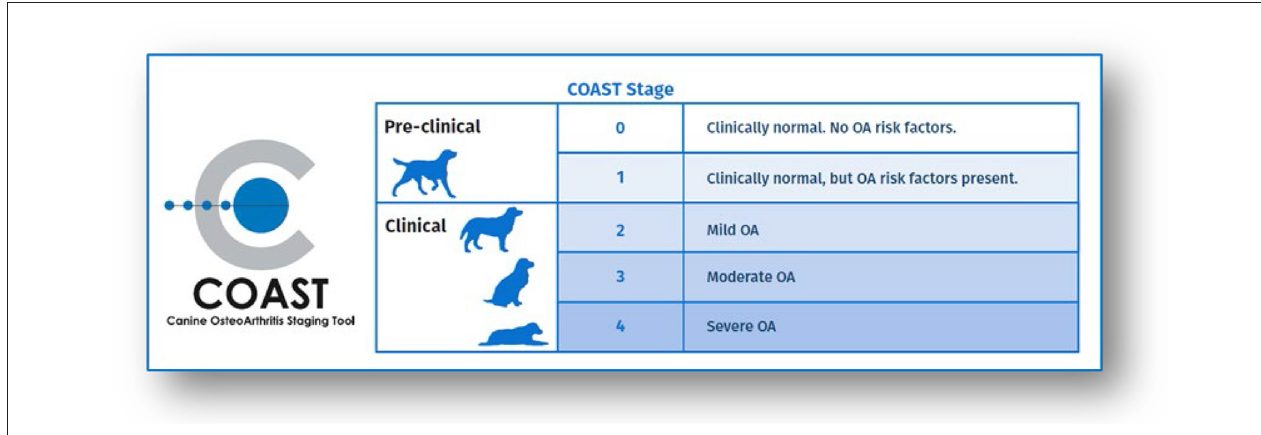
FIGURE 1 | OA stages based on Canine OsteoArthritis Staging Tool (COAST). Image courtesy of